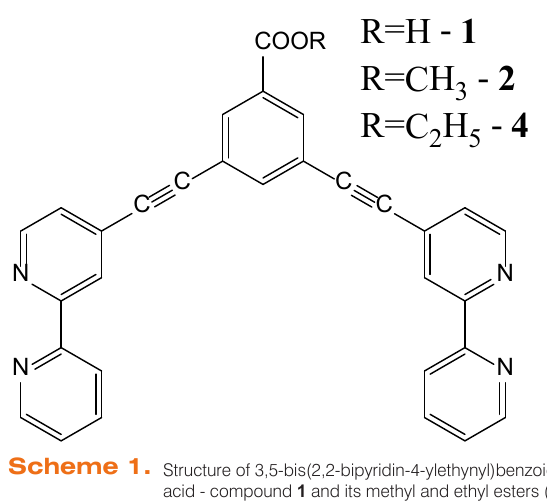
Scheme 1. Structure of 3,5-bis(2,2-bipyridin-4-ylethynyl)benzoic acid - compound 1 and its methyl and ethyl esters ( 2 and 3